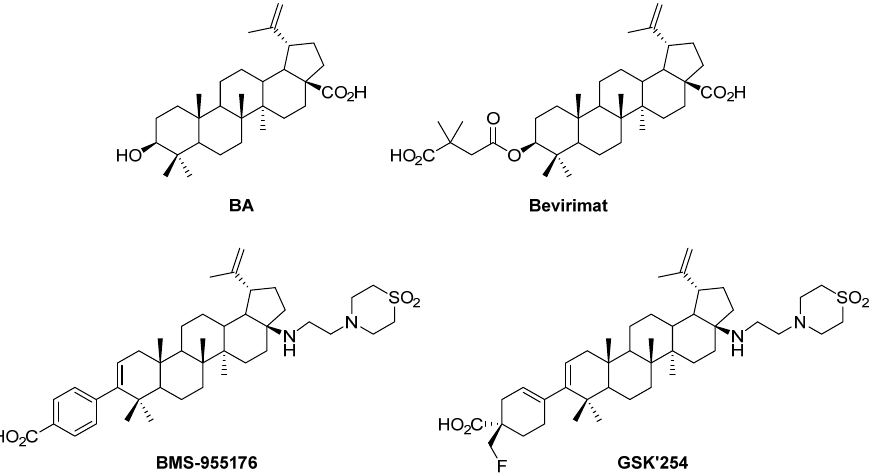
Figure 1. Structures of BA and three BA-based synthetic derivatives: bevirimat, BMS-955176 and GSK’254, known as potent anti-HIV agents.